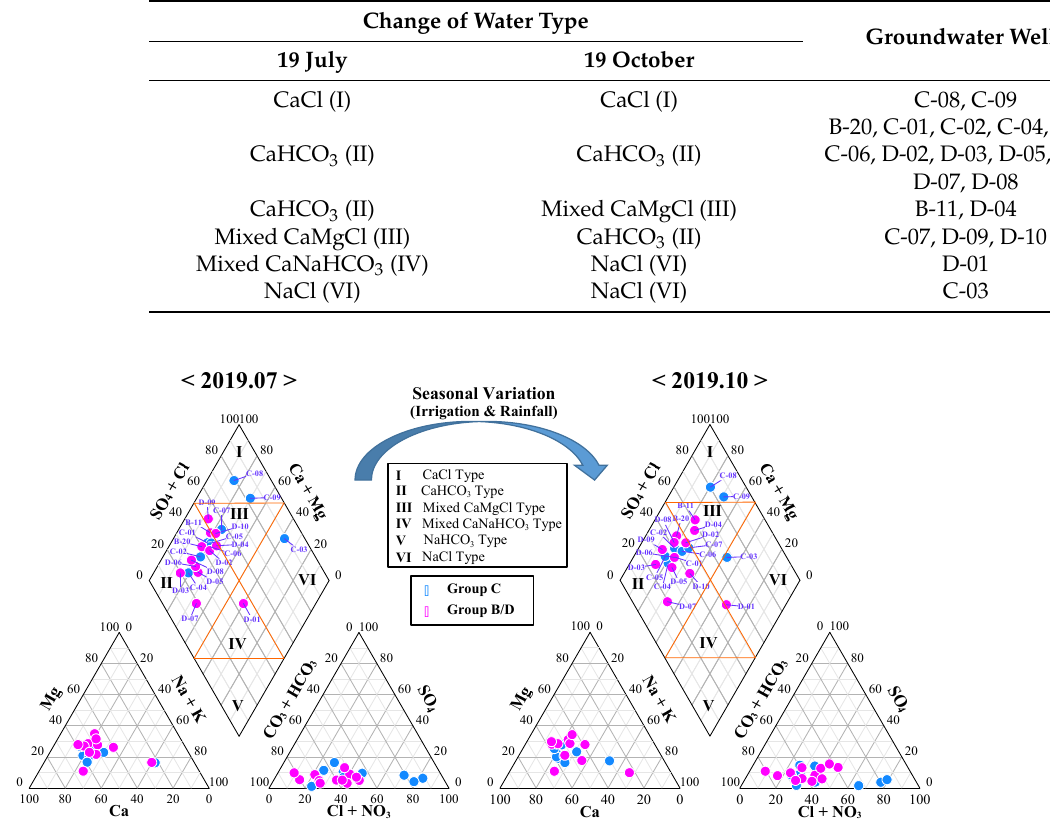
Figure 4. Piper diagrams indicating water type changes from the first survey in July 2019 to the second survey in October 2019. Table 4. Change of water types for groundwater samples in the study area.